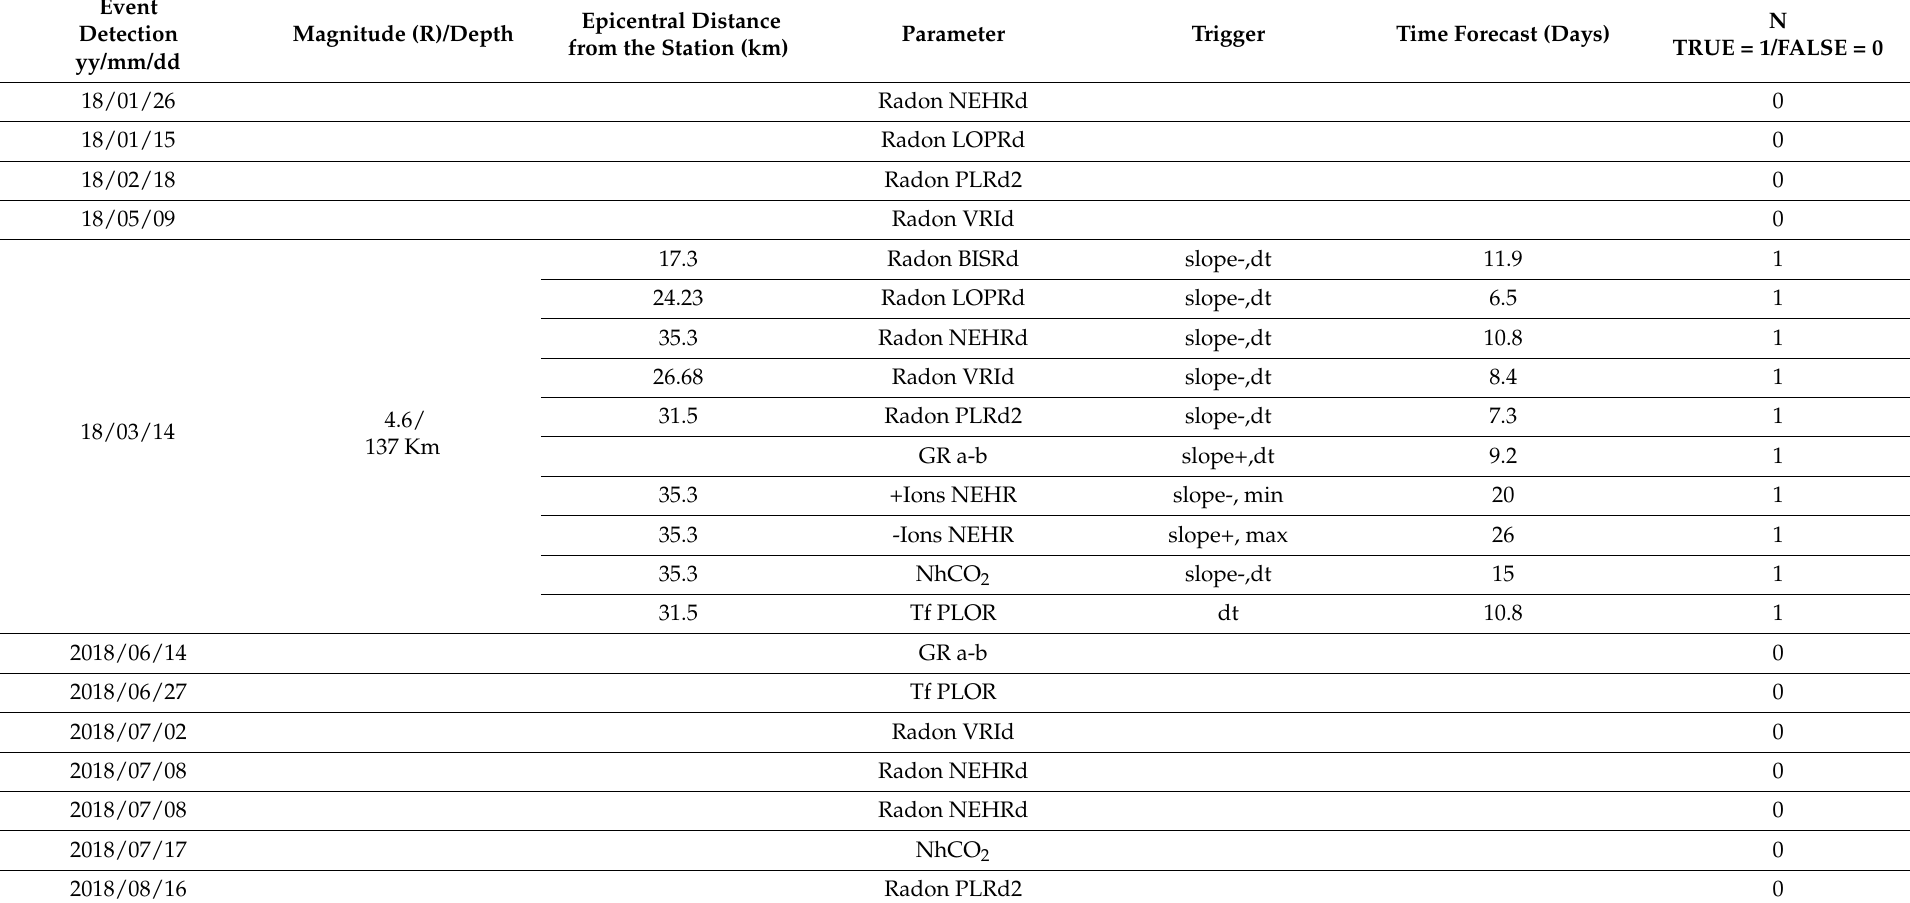
Table 3. Detection of events, time forecast, correlation with seismicity (TRUE = 1 trigger fallowed by earthquake, FALSE = 0 trigger without